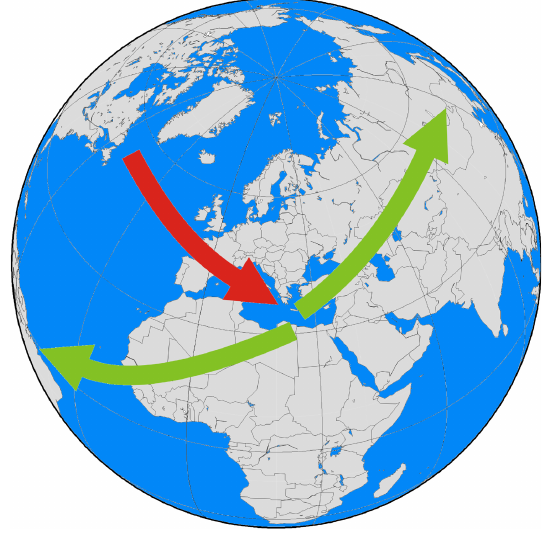
Fig. 16. Air flow crossroads over the Mediterranean basin, red the incoming air, in green the two main outflow